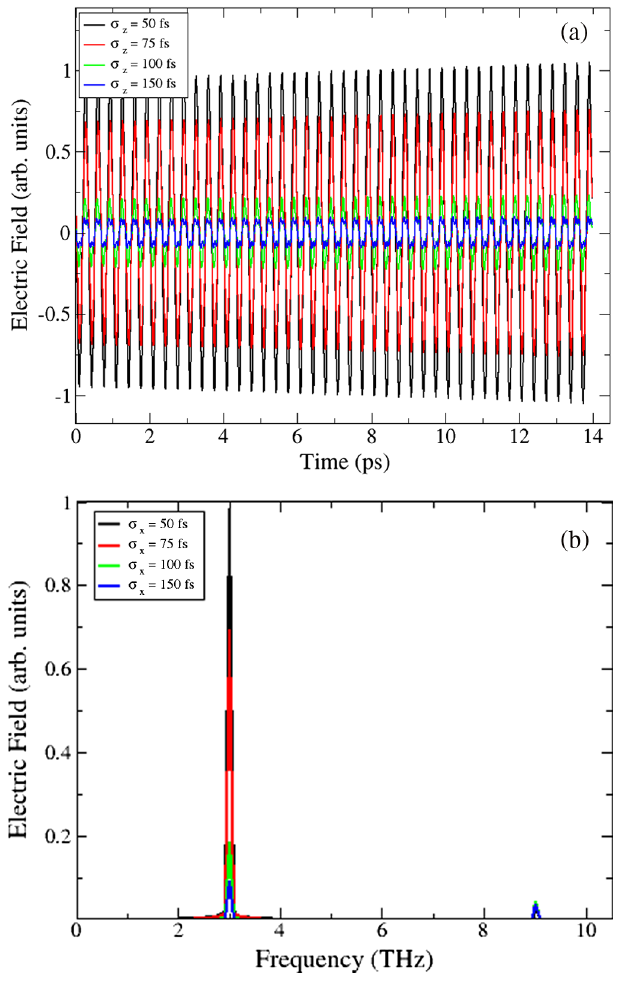
FIG. 7. Variation of temporal profile and spectrum of radiation emitted by an electron beam with bunch length. The values are normalized to the peak field obtained for the case of σ z ¼ 50 fs electron